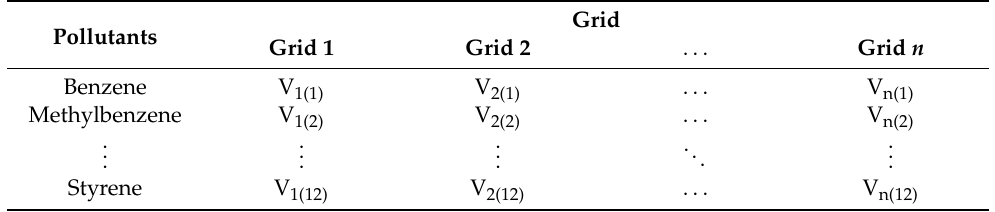
Table 2. VOCs emission values of the regional